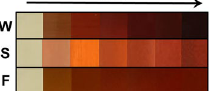
Figure 1. Color changes in biosynthesized silver nanoparticle with different parts of Carduus crispus . S-stem, F-flower and W-whole